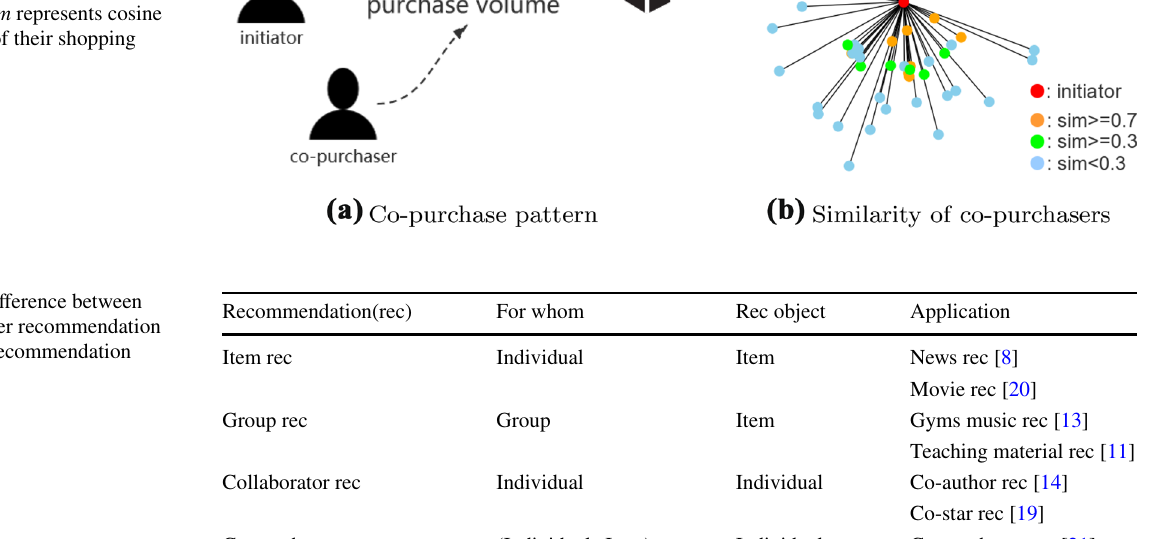
Fig. 1 A toy example of co- purchase: a simple co-purchase pattern, b similarity of co- purchasers in one co-purchase on the TaoBao. The distance ∝ between nodes their shortest path and sim represents cosine similarity of their shopping history